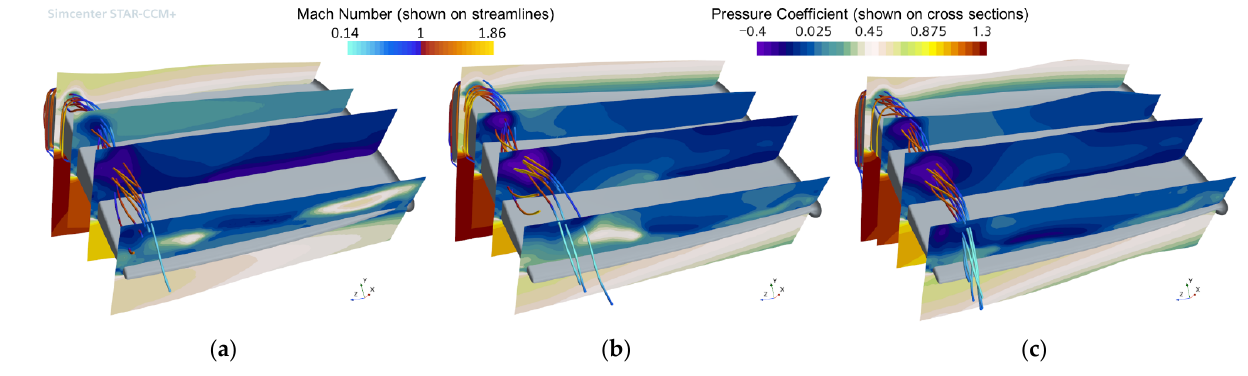
Figure 16. Tip leakage flow streamlines and pressure coefficients on spanwise cross-sections: ( a ) Baseline design; ( b ) Design A; and ( c ) Design B.